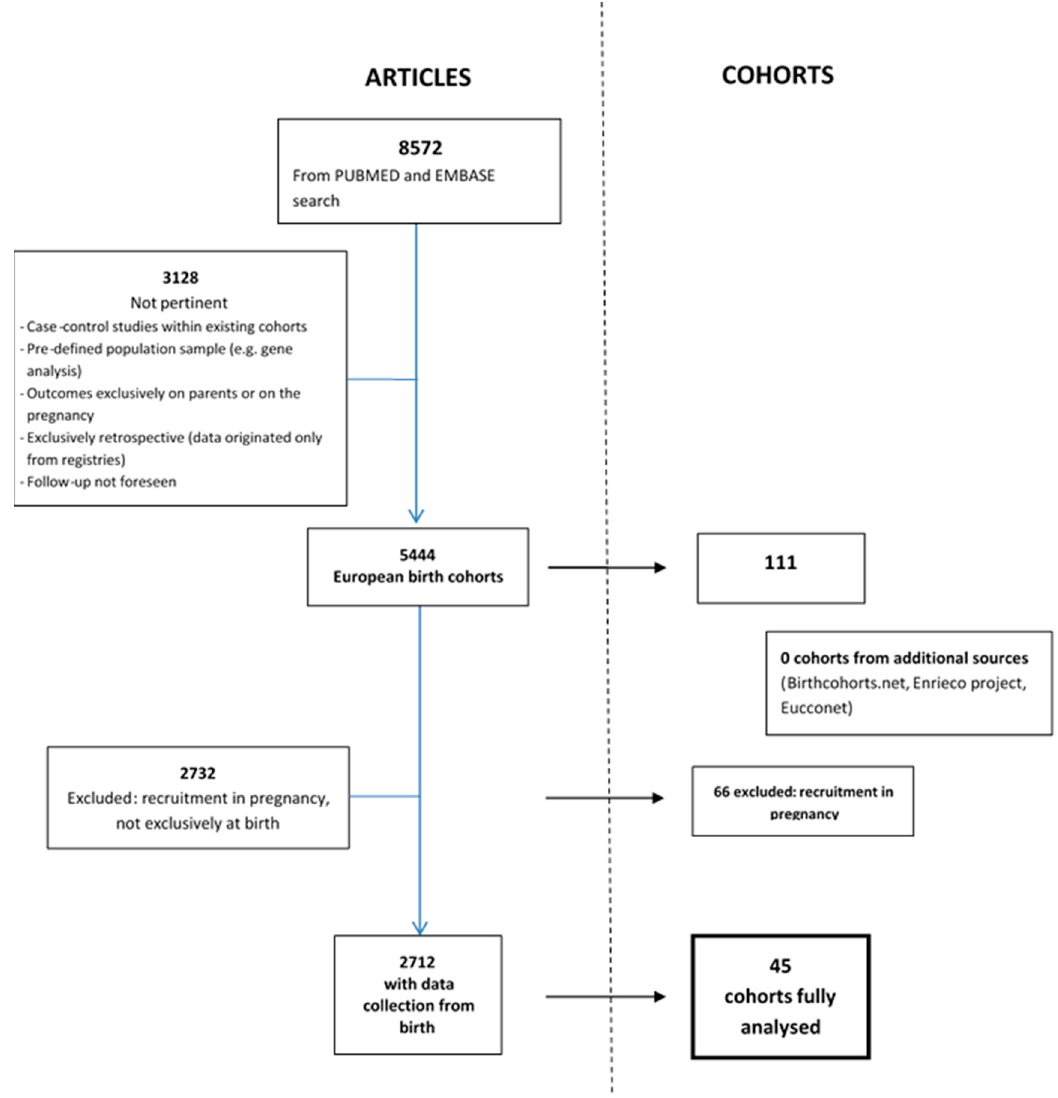
Figure 2. Selection of articles and number of related cohorts.